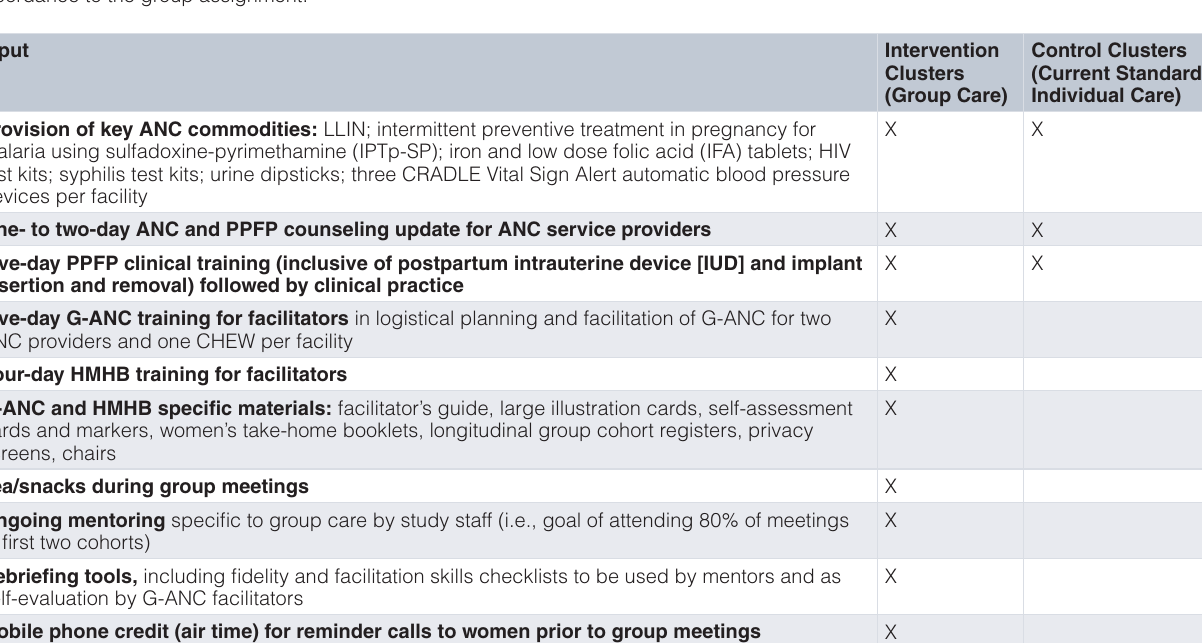
Table 3. Inputs provided to control and intervention clusters. Description of the elements of support provided to the two study arms in accordance to the group assignment. Input Intervention